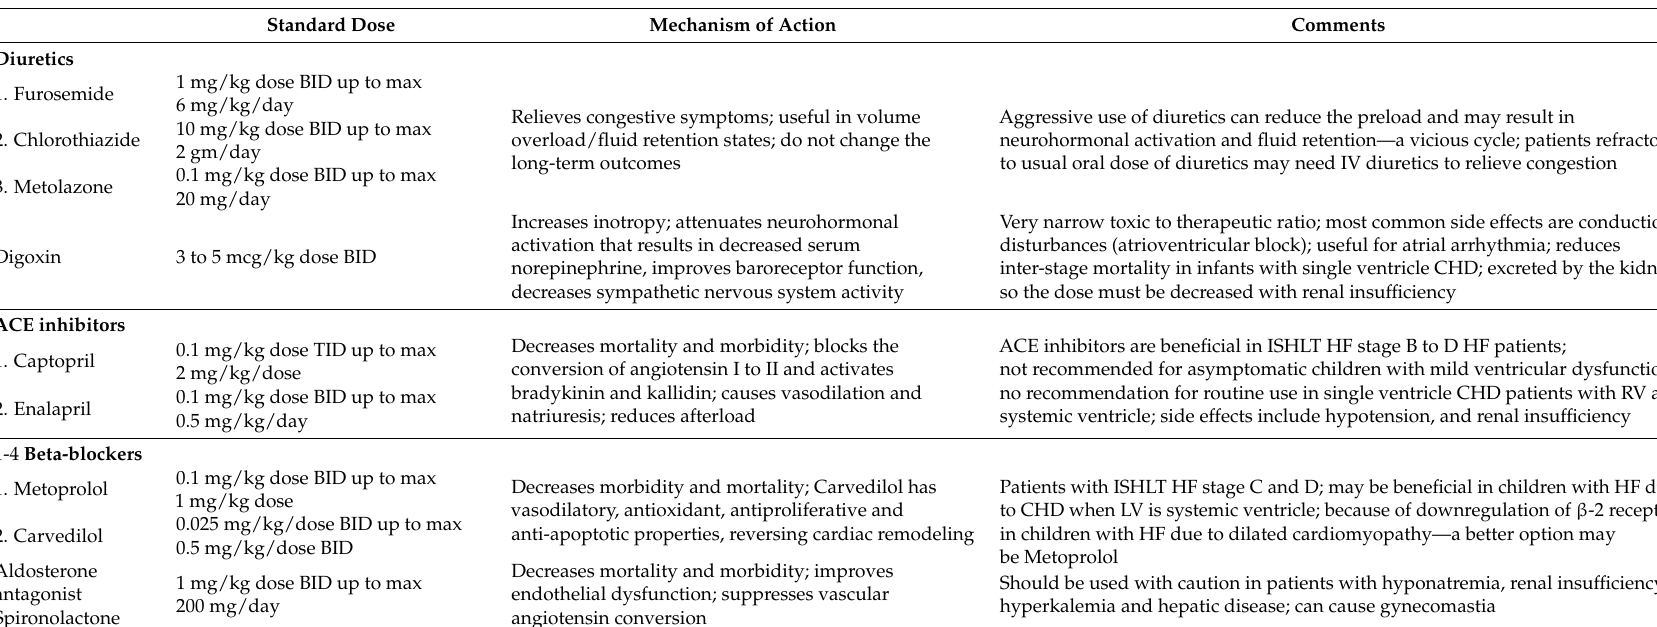
Table 4. Conventional pharmacotherapy of chronic heart failure in